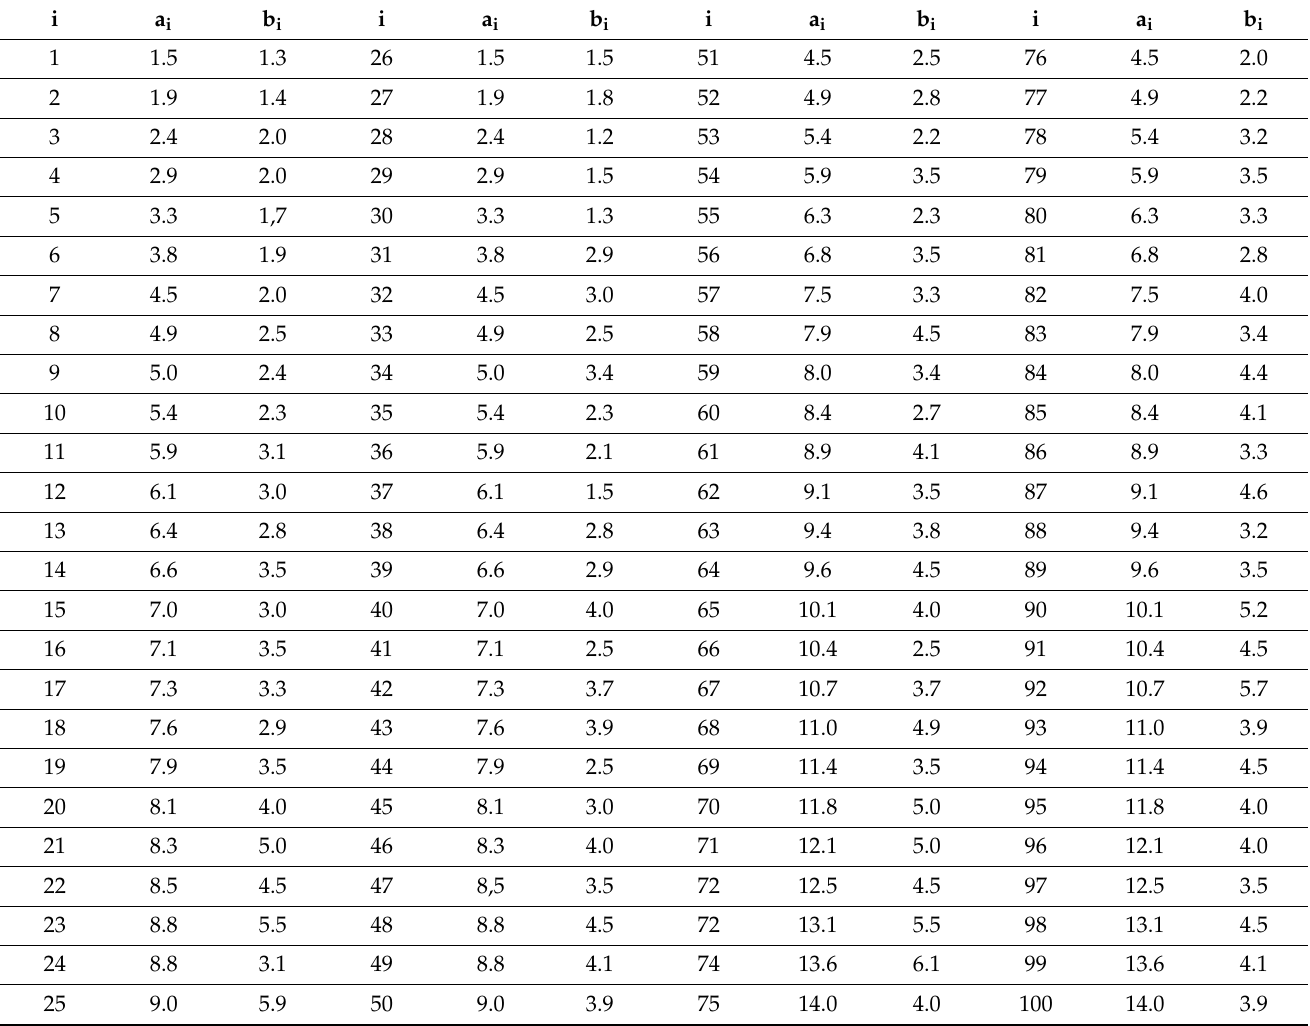
Table A1. Metrical parameters of